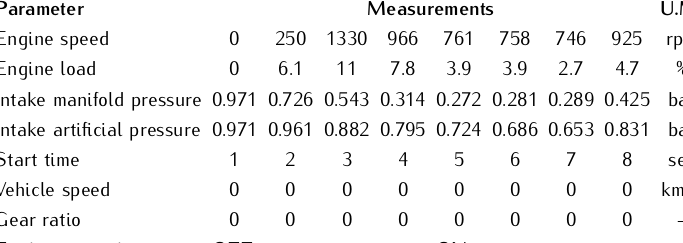
Table 2. Experimental data for cold-start condition